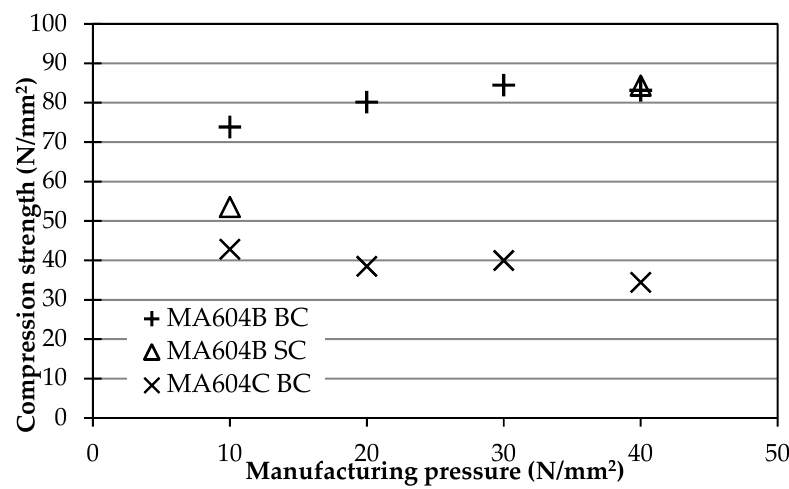
Figure 17. Compression strength (average of four tests) of recipes based on grinding sludge and oxy-cutting fines with and without fibres.